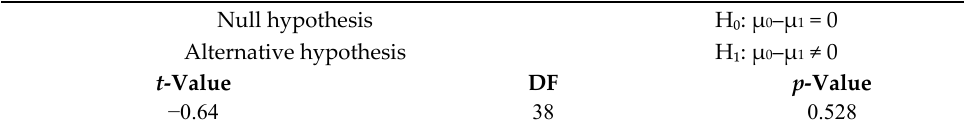
Figure 13. Lean t -tests.